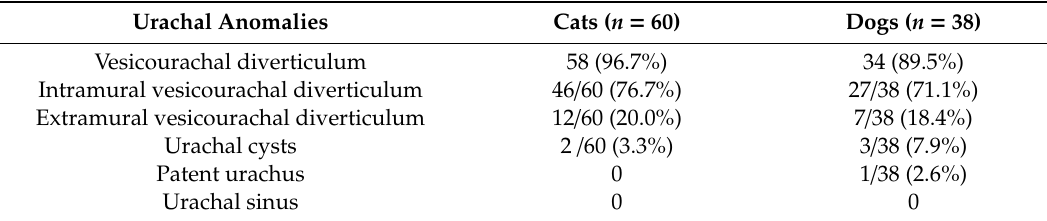
Table 1. Prevalence of the different type of Urachal Anomalies.